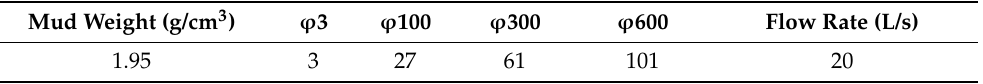
Table 2. Drilling fluid performance and drilling parameters for well